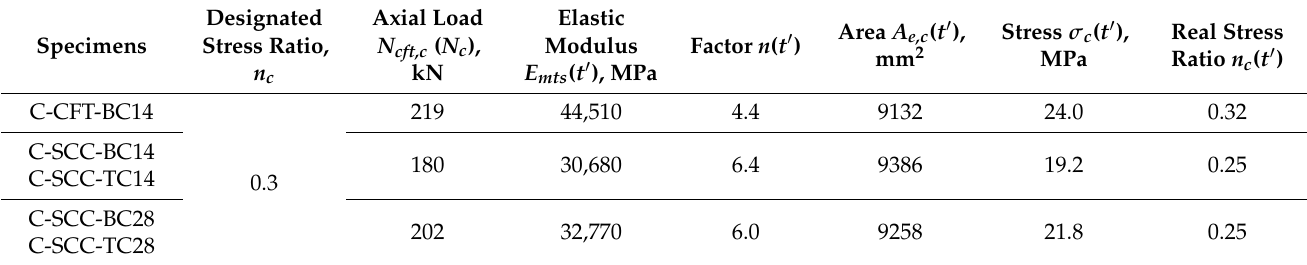
Table 4. Conversion of designated stress ratio to real stress ratio by consideration of VWSG in the specimen.